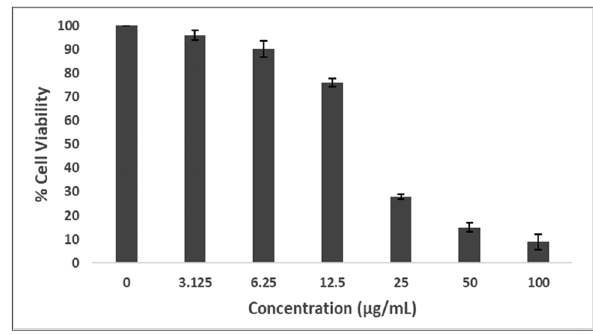
Figure 11: Cytotoxicity of green synthesized Si - AgNPs using aqueous seed extracts evaluated against cervical cancer cell lines ( HeLa cell line )